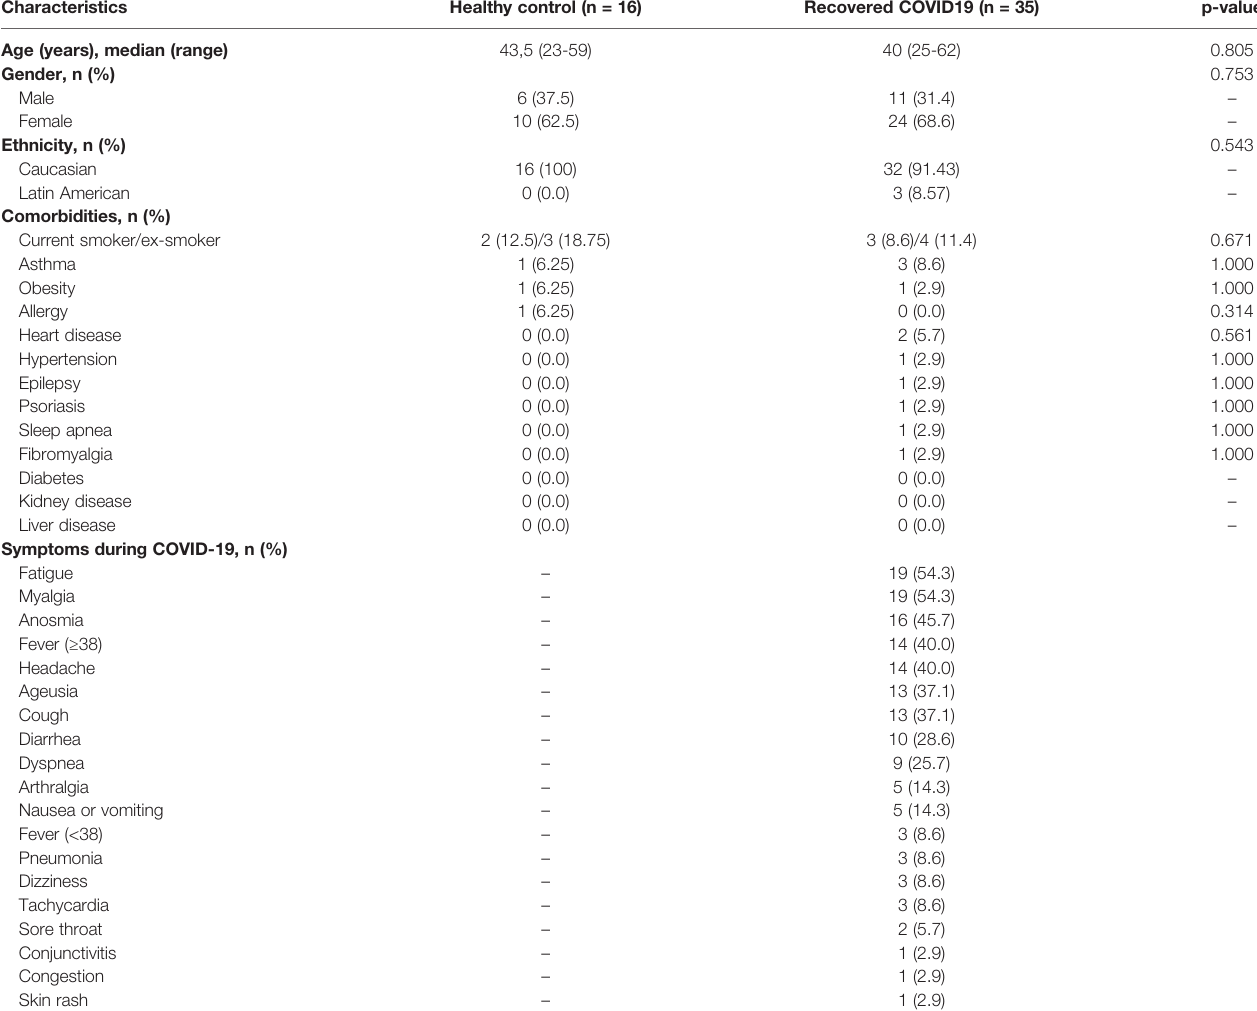
TABLE 1 | Demographic and clinical characteristics and comorbidities in healthy and recovered individuals.